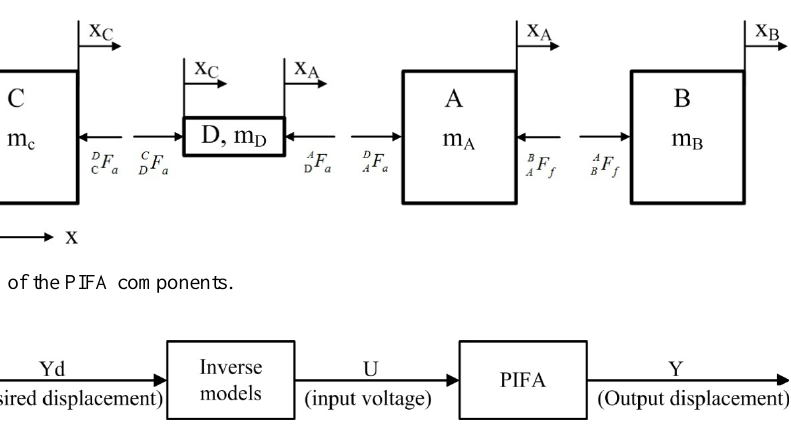
Figure 9. Principle of feed-forward